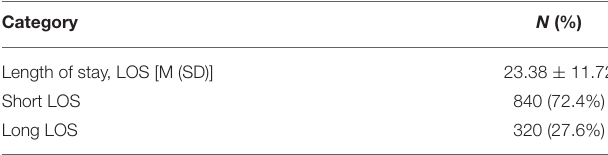
TABLE 2 | Description of the length of stay of patients with